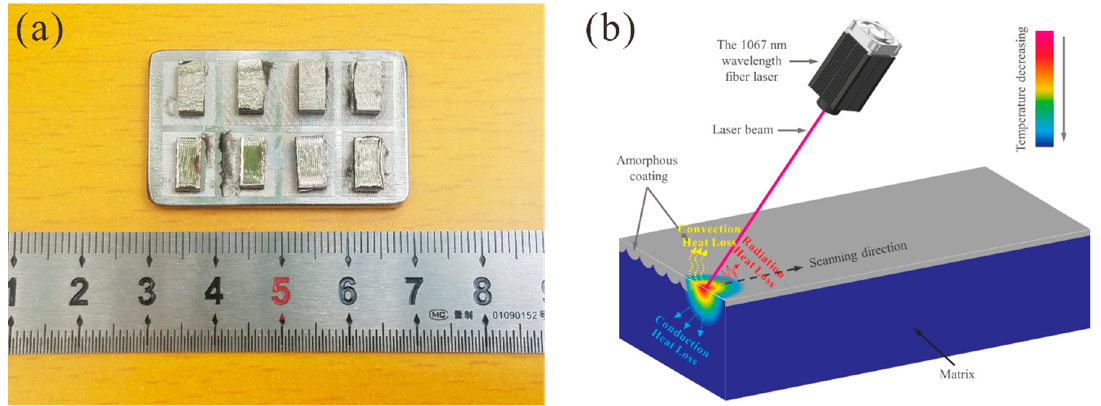
Figure 1. ( a )Theplatesamplesdisposedbydifferentlaserpowers; ( b )Schemeofthelasersurfaceremelting.